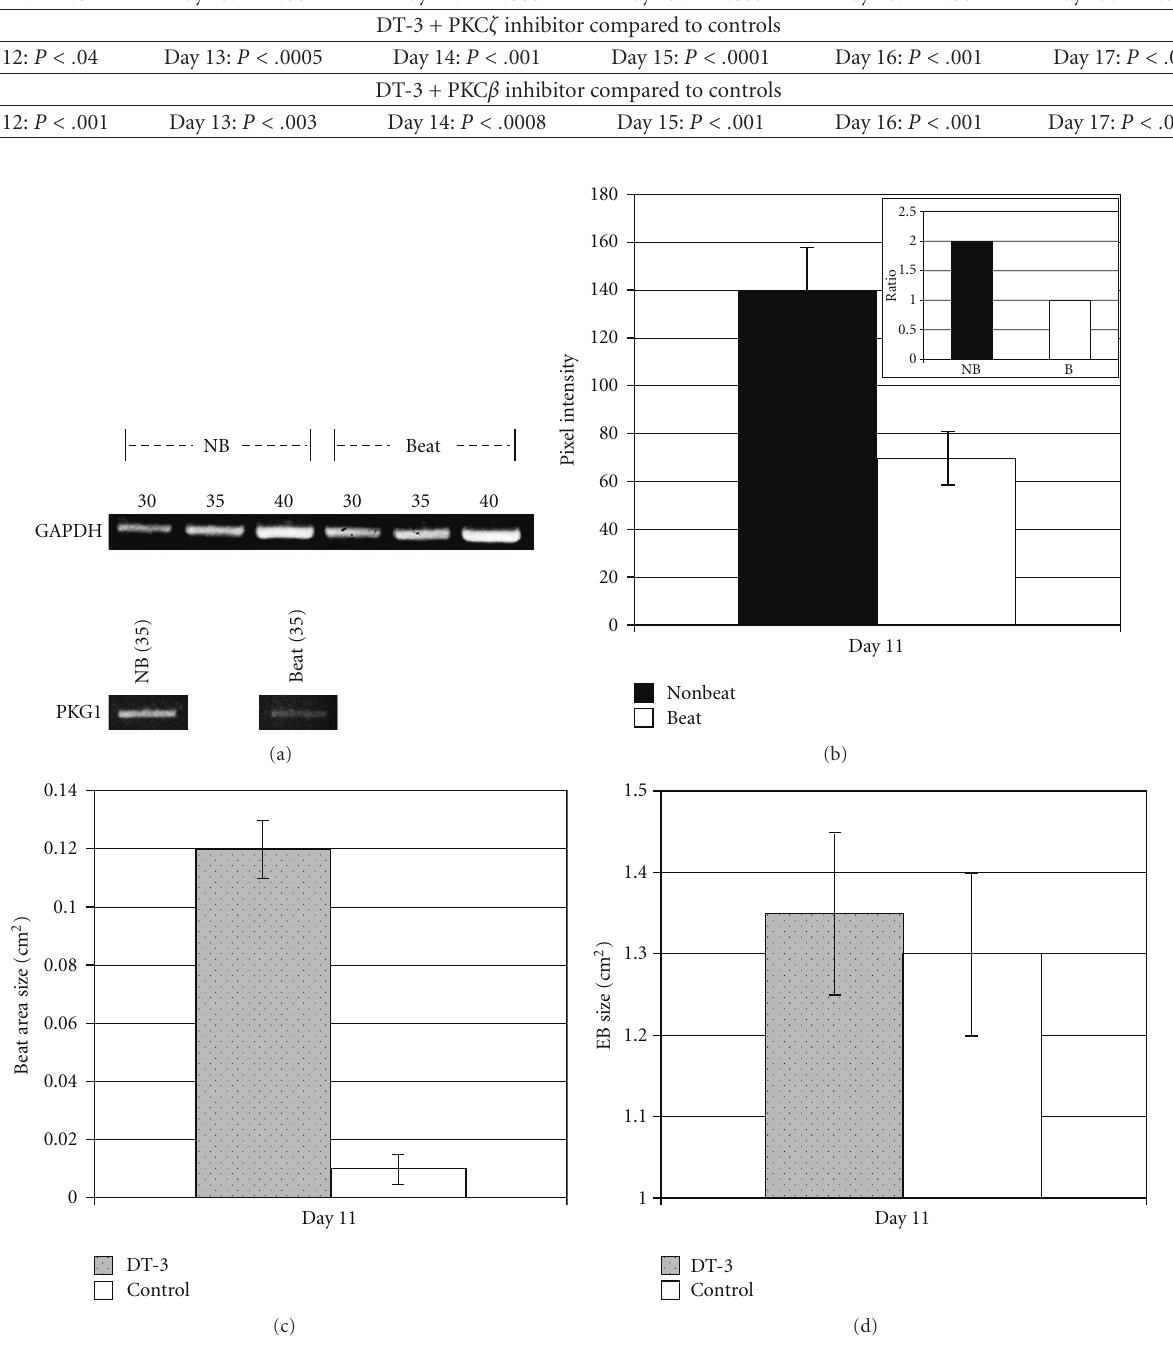
Table 1: Significance comparing treated groups to controls (for data points in Figure 3(a)) % of EBs beating. DT-3 compared to controls